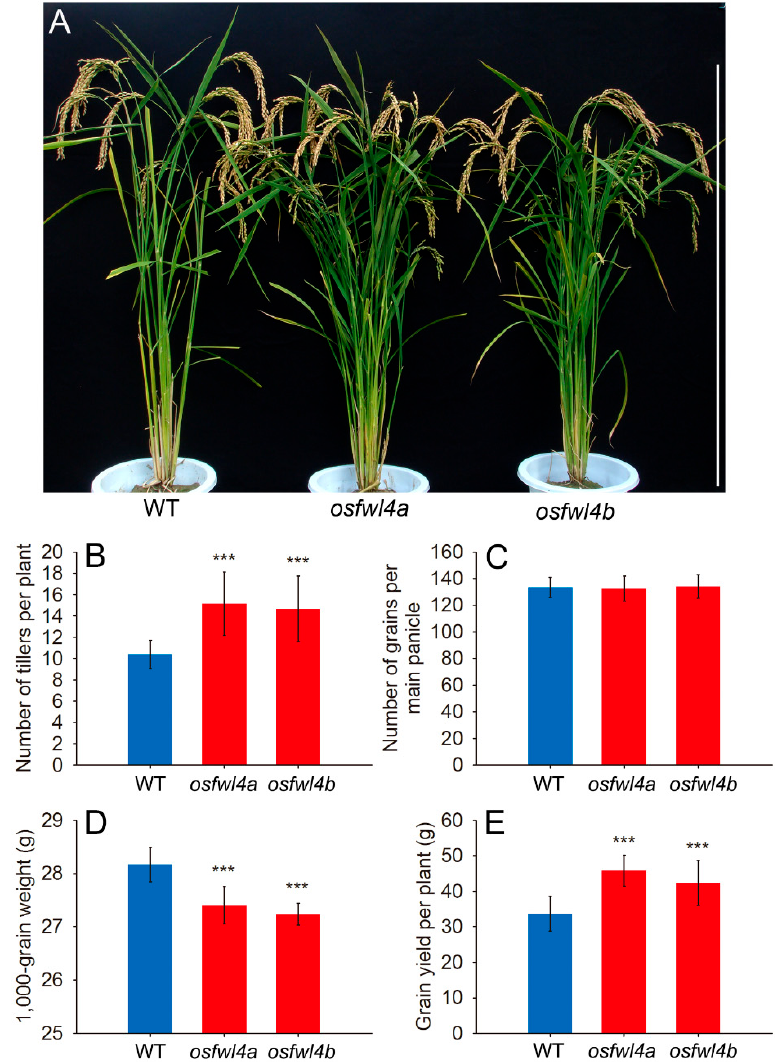
Figure 2. Analysis of yield traits of wild type (WT) and OsFWL4 gene mutants. ( A ) WT and mutant plants, bar = 1 m. ( B ) Number of tillers per plant of the WT and mutants, n = 20. ( C ) Number of grains per main panicle of the WT and mutants, n = 10. ( D ) 1000-grain weight of the WT and mutants, n = 10. ( E ) Grain yield per plant of the WT and mutants, n = 12–15. Error bars are standard deviations. *** p < 0.001.